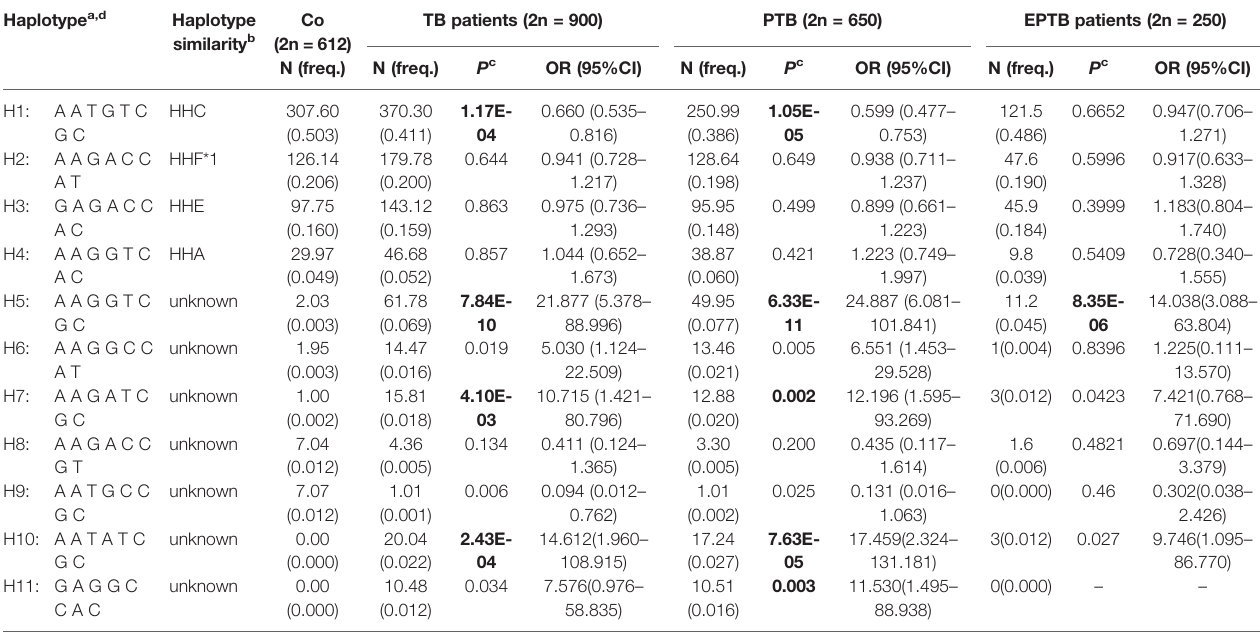
TABLE 5 | CCR5 promoter haplotype frequencies in case and control